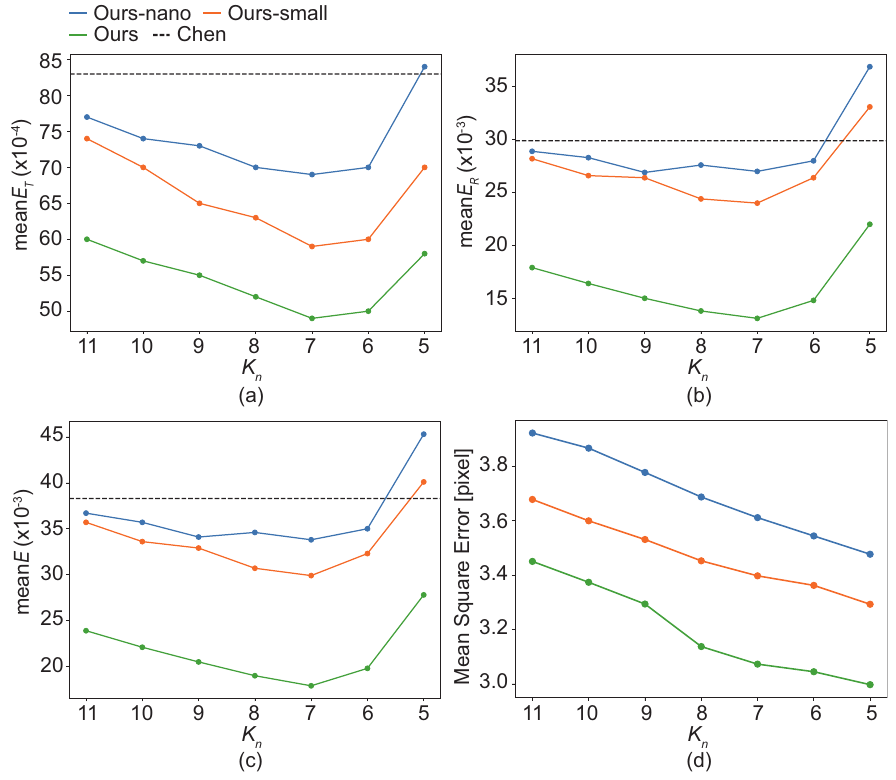
Figure 8. Performance with different K n . ( a – c ) show the change of three kinds of error with the selection of K n . ( d ) shows the change of MSE error of detected keypoints with the selection of K n